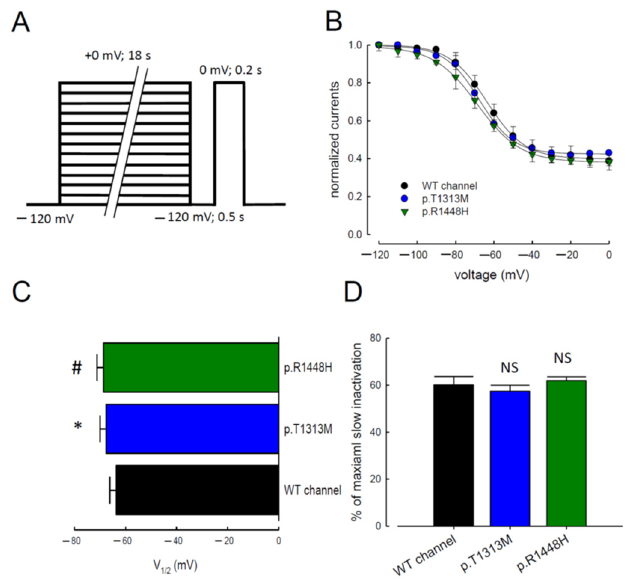
Figure 6. Slow Inactivation in the WT, p.T1313M, and p.R1448H Mutant Na v 1.4 Channels. ( A ) The patched cells were held at − 120 mV, and the pulse protocol was repeated every 30 s. Inactivating prepulses of different voltages (from − 120 to 0 mV, ~18 s) were followed by a gap voltage at − 120 mV for 0.5 s (to allow recovery from fast inactivation), after which the fraction of available channels was measured by a test pulse at 0 mV for 0.2 s. ( B ) The normalized peak Na + currents were reported as a function of the conditioning pulse voltage. The WT, p.T1313M, and p.R1448H mutant Na v 1.4 channels were fitted to slow inactivation curves using Boltzmann function, including a residual current of the formula: I R + (1 − I R )/[1 + exp ((V − V 1/2 )/k)], where V is the membrane voltage. Since some channels do not enter slow inactivation, residual current (I R ) was introduced into the equation to fit the voltage dependence of slow inactivation. V 1/2 is the half-maximal voltage of slow inactivation and k is the slope factor. ( C ) The horizontal bar graph shows the V 1/2 shift